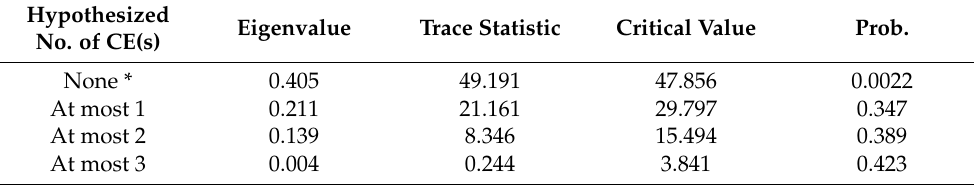
Table 4. Results of Johansen cointegration test.